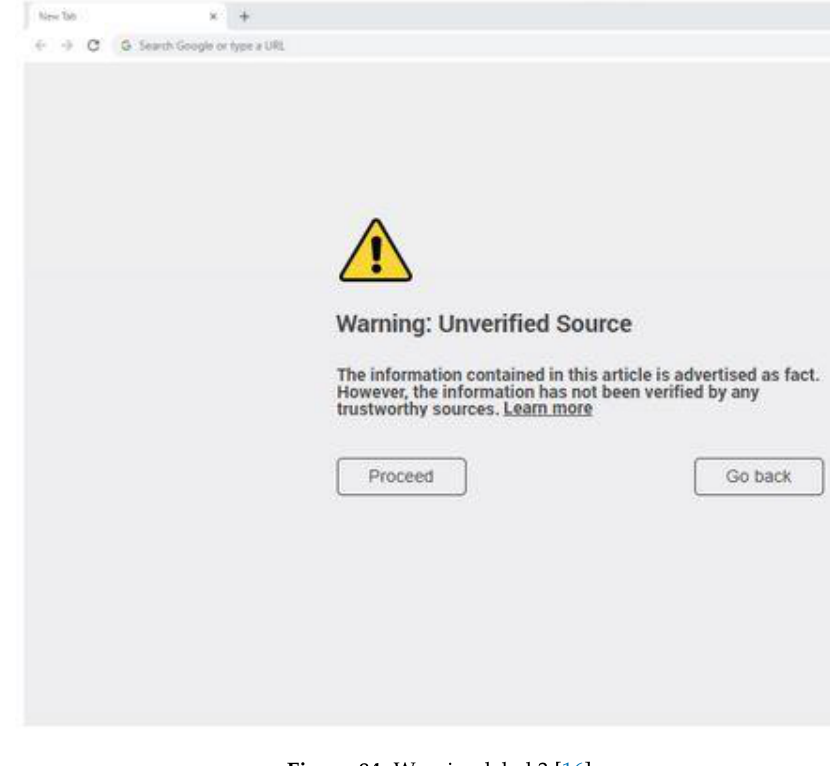
Figure 84. Warning label 3 [16].